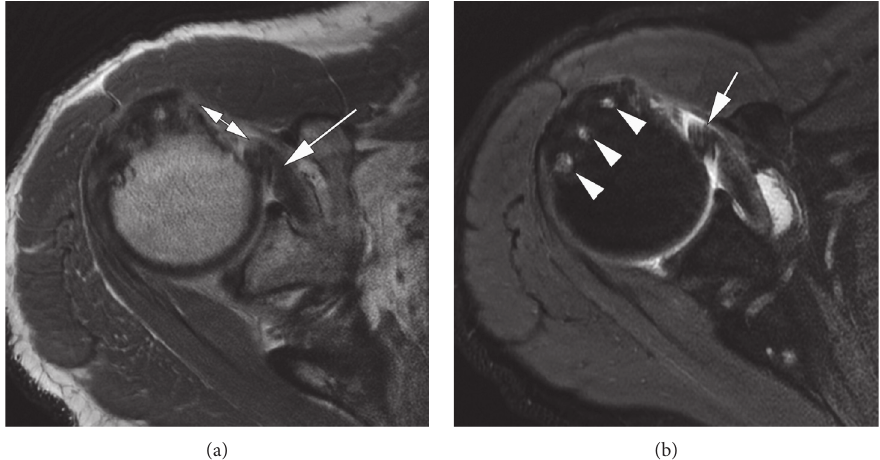
Figure 5: A 49-year-old man with right shoulder pain and inability to extend the right arm after a fall. Axial PD-weighed MRI (a) demonstrates a full-thickness subscapularis tendon tear (long arrow) with medial retraction (short double-headed arrow). Axial T2-weighed FS MRI (b) shows multiple subchondral cysts at the greater tuberosity (arrowheads), which is an associated finding with rotator cuff tears. In addition, there is a medial displacement of the long head of the biceps tendon